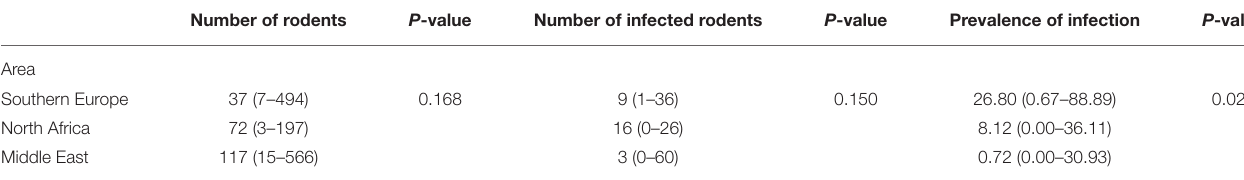
TABLE 2 | Median (rank) of studied variables according to the geographical area. Number of rodents